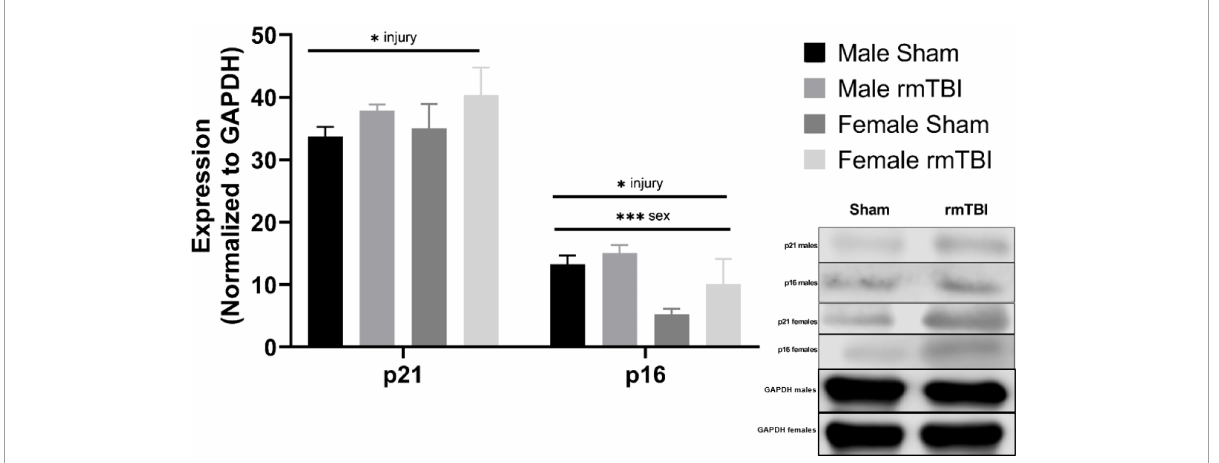
FIGURE4 Cellular senescence is evident 1 week post-injuries. Using Western Blotting, protein levels of p21 and p16 were assessed. One week post-injuries p21 was significantly elevated in rmTBI mice compared to shams ( p = 0.01, main effect of injury). There was no significant effect of sex on p21 expression. p16 expression was significantly increased in rmTBI mice compared to shams ( p = 0.01, main effect of injury) and significantly differed between sexes ( p = 0.001, main effect of sex) with no interactive effect. Post-hoc testing revealed significantly higher p16 expression in male shams compared to female shams ( p = 0.001, Tukey HSD), female rmTBI compared to female shams ( p = 0.05, Tukey HSD), and male rmTBI compared to female rmTBI ( p = 0.04, Tukey HSD). All statistical values are results of two-way ANOVAs with n = 4 per sex-segregated group. Error bars represent standard deviation. Indication of statistical significance is as follows: # p < 0.01, ∗ p < 0.05, ∗∗ p < 0.01, ∗∗∗ p < 0.001.